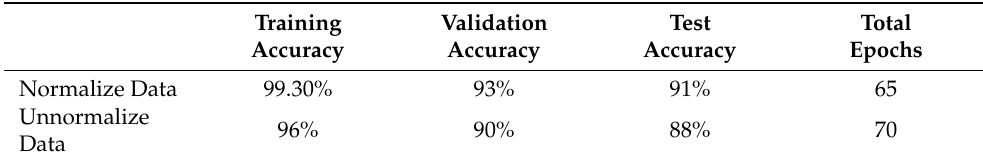
Table 2. Effect of normalization on